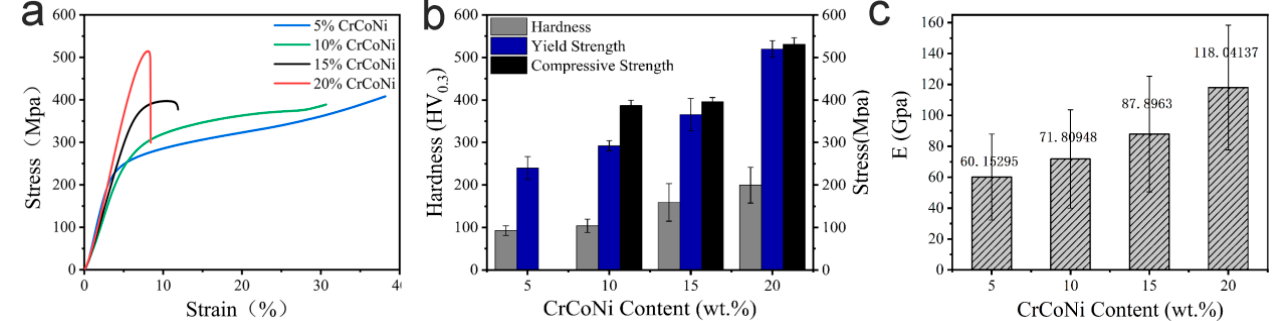
Figure 7. Mechanical properties of the fabricated composites, ( a ) compression stress-strain curves of the composites, ( b ) hardness, compressive strength and yield strength of the composites, ( c ) the elastic modulus results of the composites.